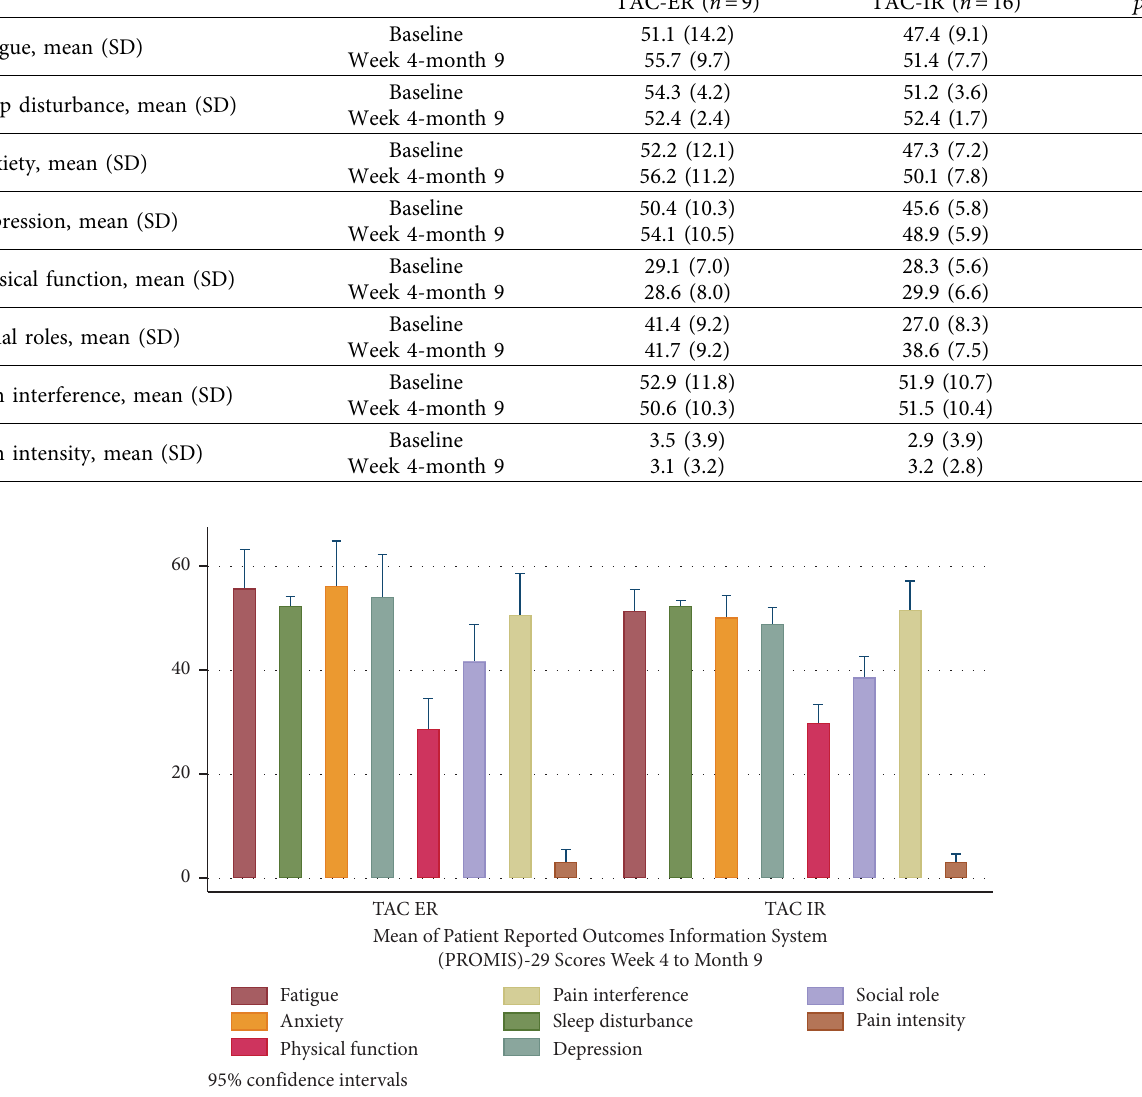
Figure 2: Mean trough levels in the TAC ER and TAC IR groups (week 1 through month